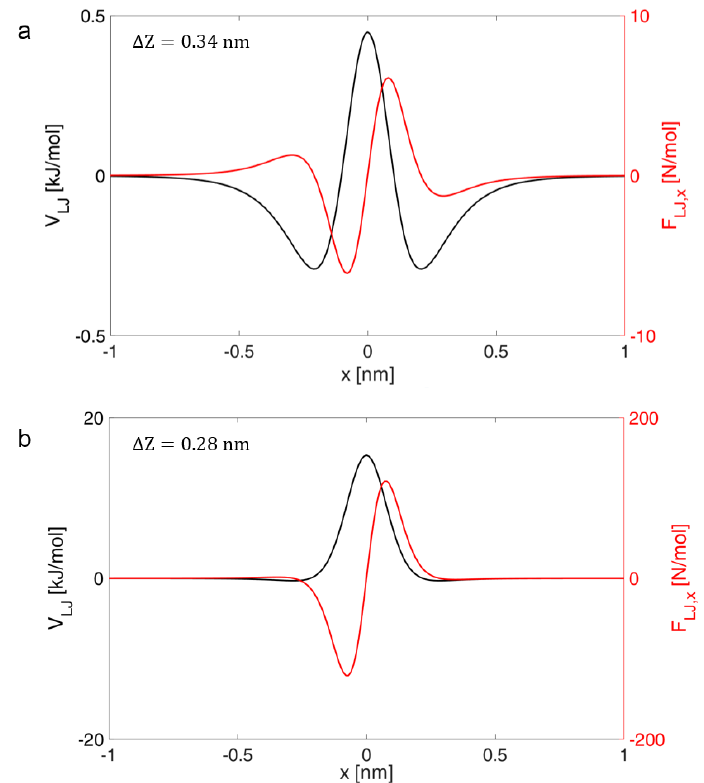
Figure 2. Interatomic van der Walls (vdW) potential (black lines) and force along the x direction (red lines) between two atoms of carbon (see configuration in Figure 1a), for ( a ) ∆ Z = 0.34 nm and ( b ) ∆ Z = 0.28